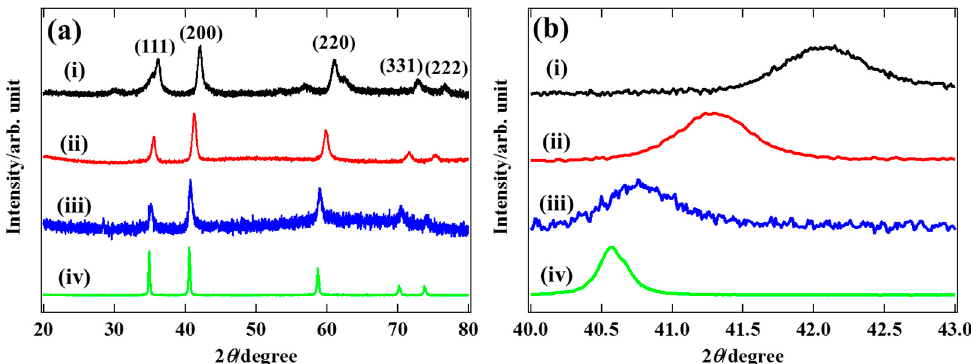
Figure 6. ( a ) XRD patterns of nanoparticles. ( b ) Enlarged (200) peak to show the peak shift. (i)–(iv) are as indicated in Table 1.